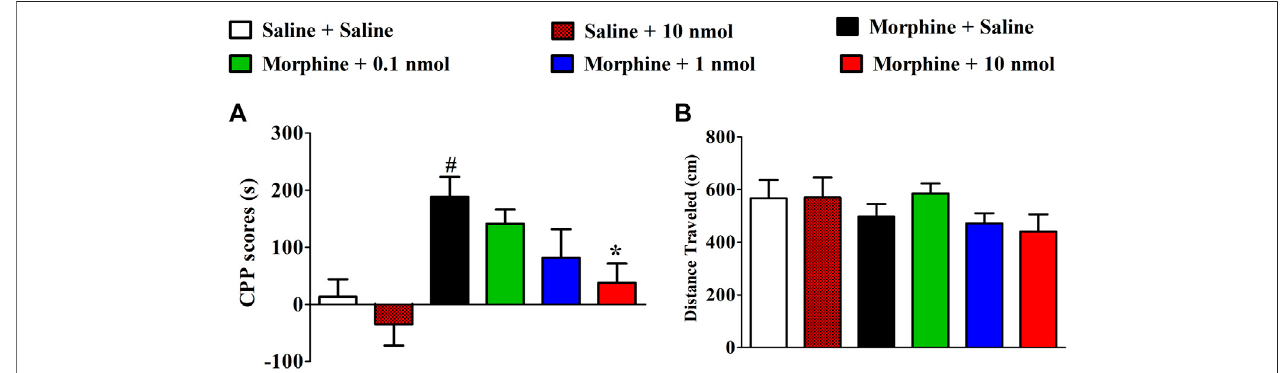
FIGURE4| Effectsof α -conotoxinTxIBontheexpressionofmorphine-inducedCPP.Resultsareexpressedasmeanpreferencescores ± SEMsfor9 – 12mice. (A) The CPP scoresofpost-conditioning test, CPP scores (cid:1) thetimespent in drug-paired compartmentafter administration — preconditioning. ANOVA for theCPP scores: F 5,63 (cid:1) 4.72, p < 0.05; (B) the distance traveled on the post-conditioning test day. ANOVA for the traveled distance: F 5,63 (cid:1) 1.07, p (cid:1) 0.38; # denotes a signi fi cant difference from the saline + saline group; * denotes a signi fi cant difference from the morphine + saline group (# (cid:1) p < 0.05,* (cid:1) p < 0.05).